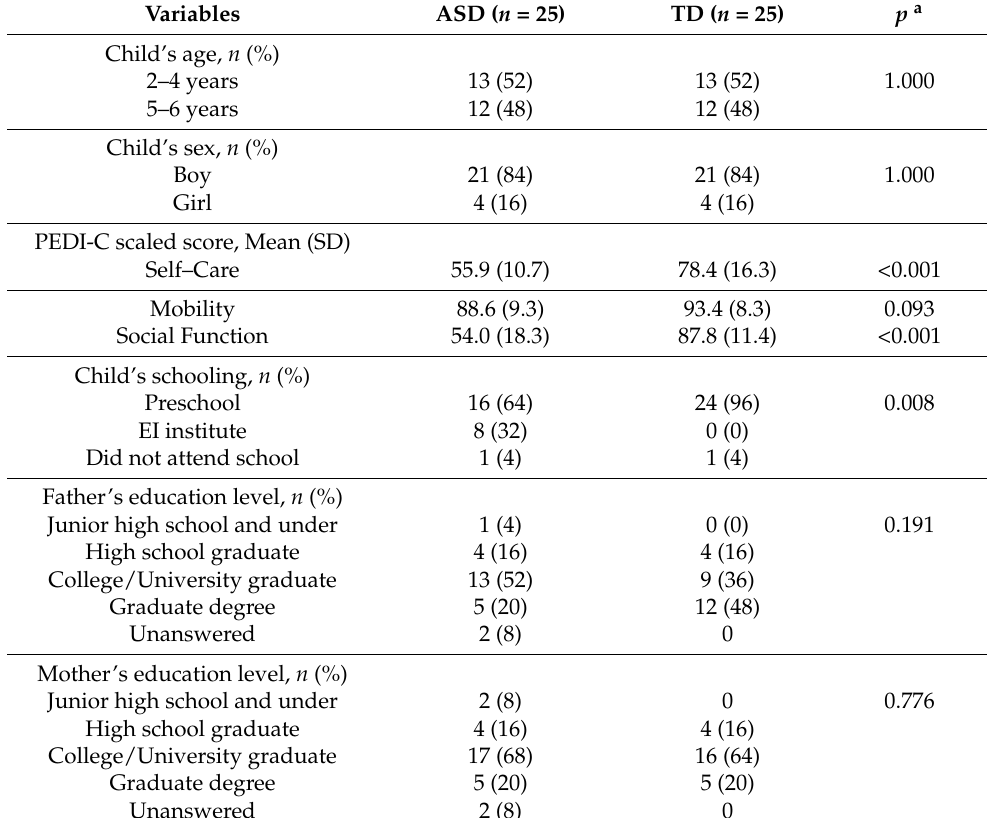
Table 1. The Characteristics of